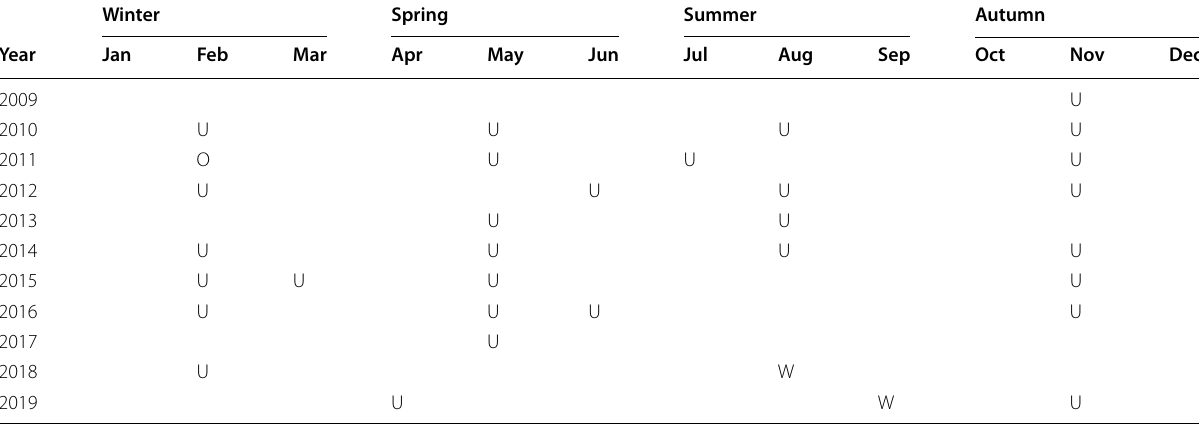
Table 2 Implementation record of hydrographic observations along the Shiriya–Esan (SE) line. U, O, and W represent the observations made by T/S Ushio-Maru , T/S Oshoro-Maru , and R/V Wakataka-Maru , respectively